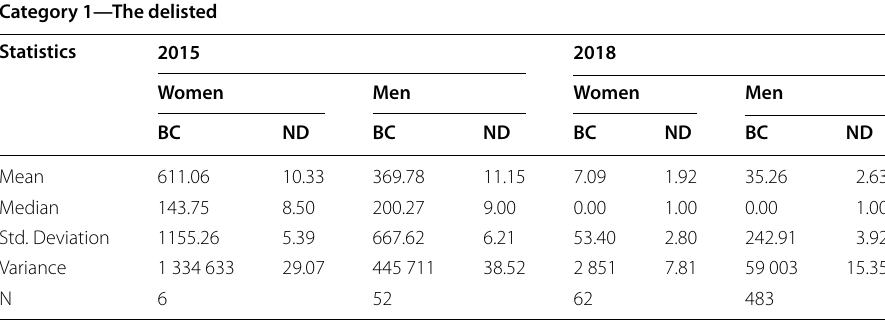
Table 6 Category 1—The Delisted: directors in the 2015 network who left or BC became 0 Category 1—The delisted